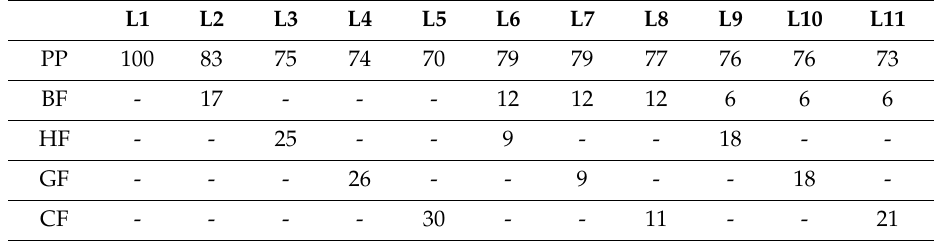
Table 5. Compositions of the prepared composites L1–L11 showing the fiber content in wt % (modified table